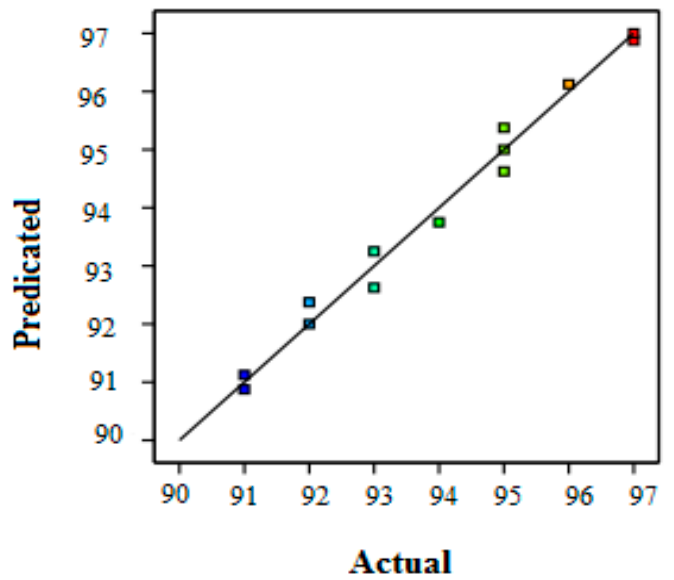
Figure 2. Comparison of calculated and predicted values for COD removal by